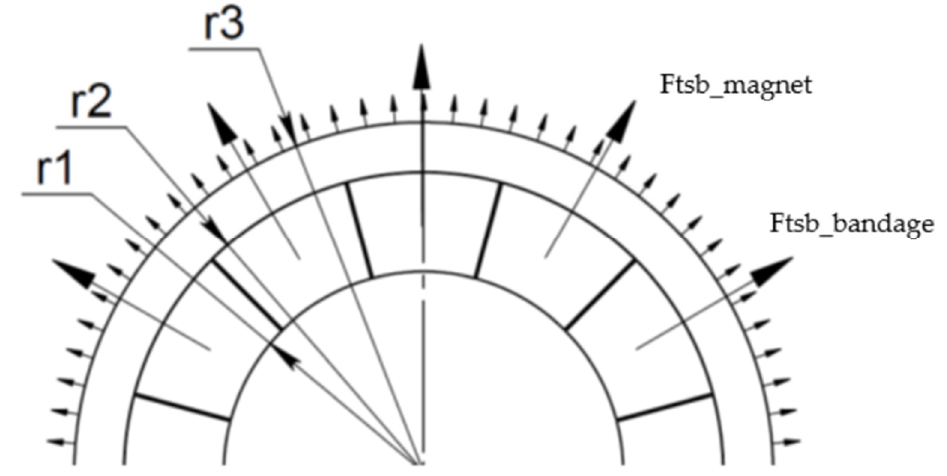
Figure 4. The geometry of the bandage and the centrifugal forces acting on it.